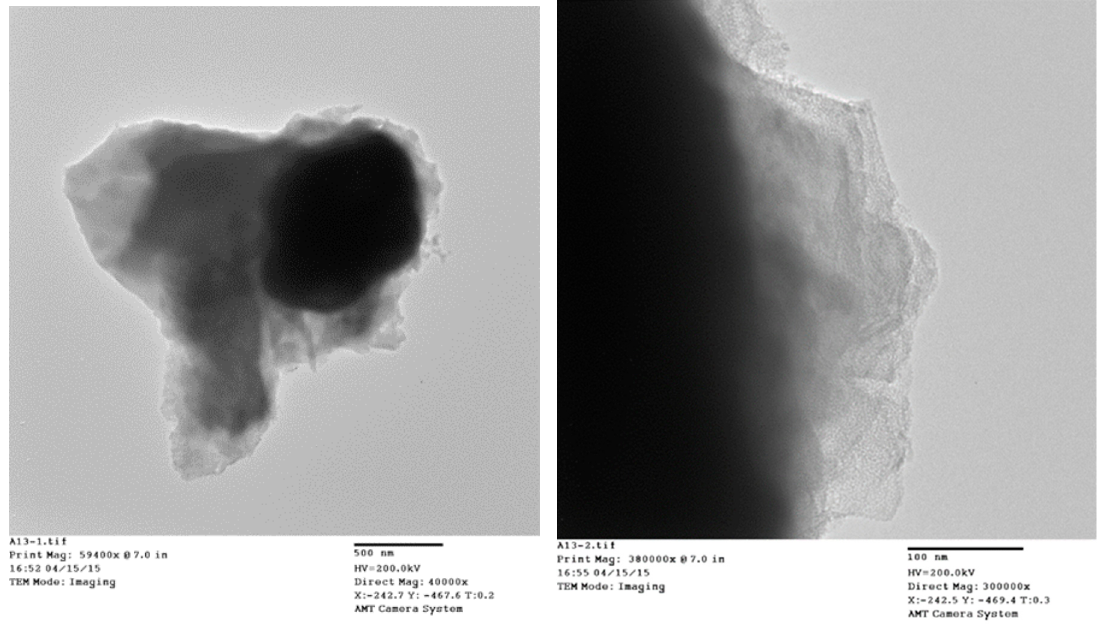
Figure 3. Transmission electron microscopy (TEM) micrographs at ( a ) ×40,400 and ( b ) ×300,000 magnification of AR3 cycled in the 6.44 M KOH + 0.33 M Cs 2 CO 3 electrolyte.